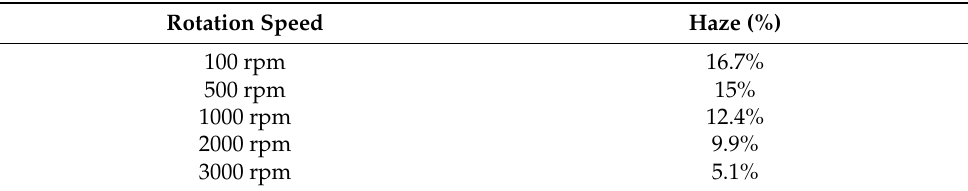
Figure 10. UV-Visible diffusion reflection spectra of CuCrO 2 thin films prepared at different rotat- ing speeds from 100 to 3000 rpm and annealed at 600 °C.